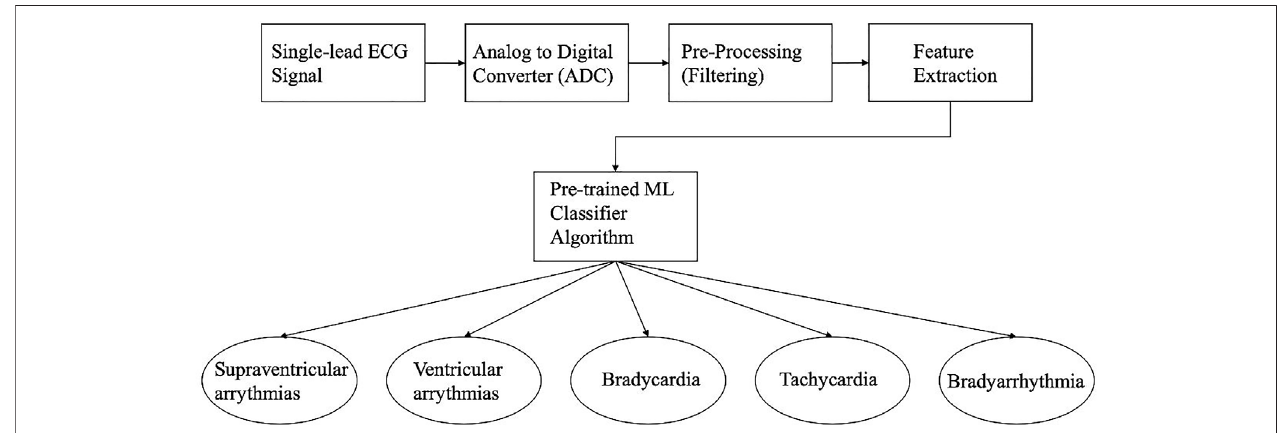
FIGURE 3 | Block diagram of Single-lead ECG with feature extraction and a Machine Learning Classi fi er that classi fi es the 5 different types of cardiac